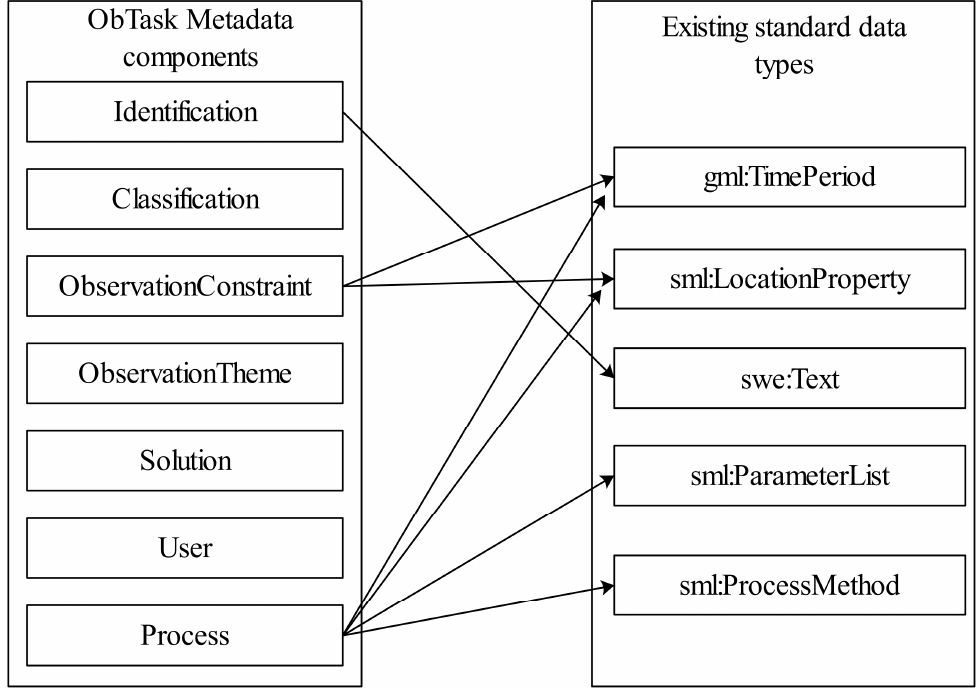
Figure 5. Mapping of the earth observation task contents to existing standard data types.